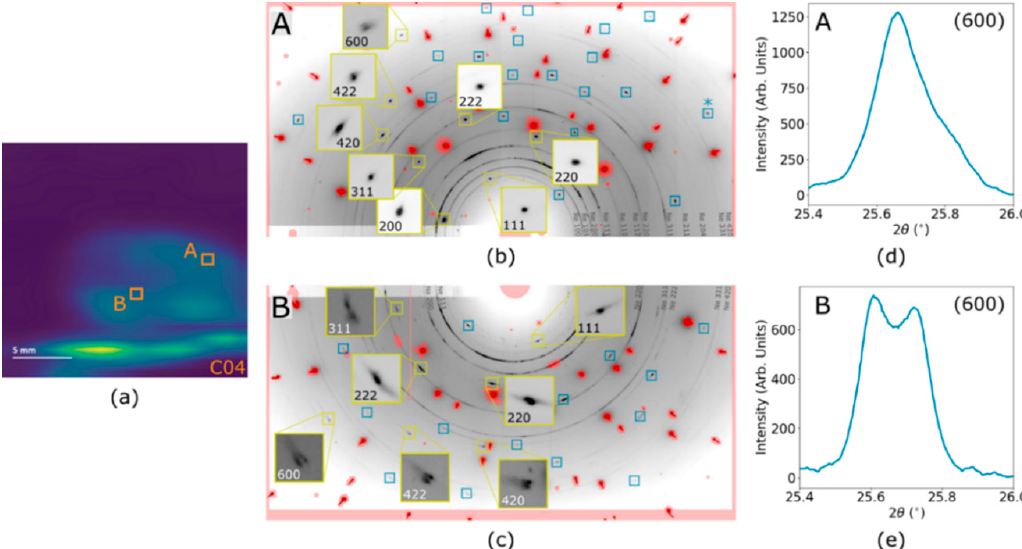
Figure 7. Splitting of Bragg reflections of ferropericlase after pulse laser heating of C04 crystal in Experiment 2 (53.5 GPa). ( a ) X-ray di ff raction map of the crystal showing the relative intensity of the (220) reflection of ferropericlase at the selected positions at the edge (“A”) and close to the center (“B”) of the heated area; ( b ) and ( c ) show 2D di ff raction patterns for positions A and B respectively, with selected reflections magnified (yellow rectangles). Diamond reflections and inactive areas of the detector (including edges) are masked (red areas). The rest are ferropericlase peaks marked by blue rectangles. Continuous di ff raction rings are due to Ne. ( d ) and ( e ) Integrated di ff raction profiles of Bragg (600) reflection (marked by blue asterisk on ( b )) of ferropericlase at positions A and B of the crystal respectively. Representative powder di ff raction patterns of positions A and B are presented in Figure